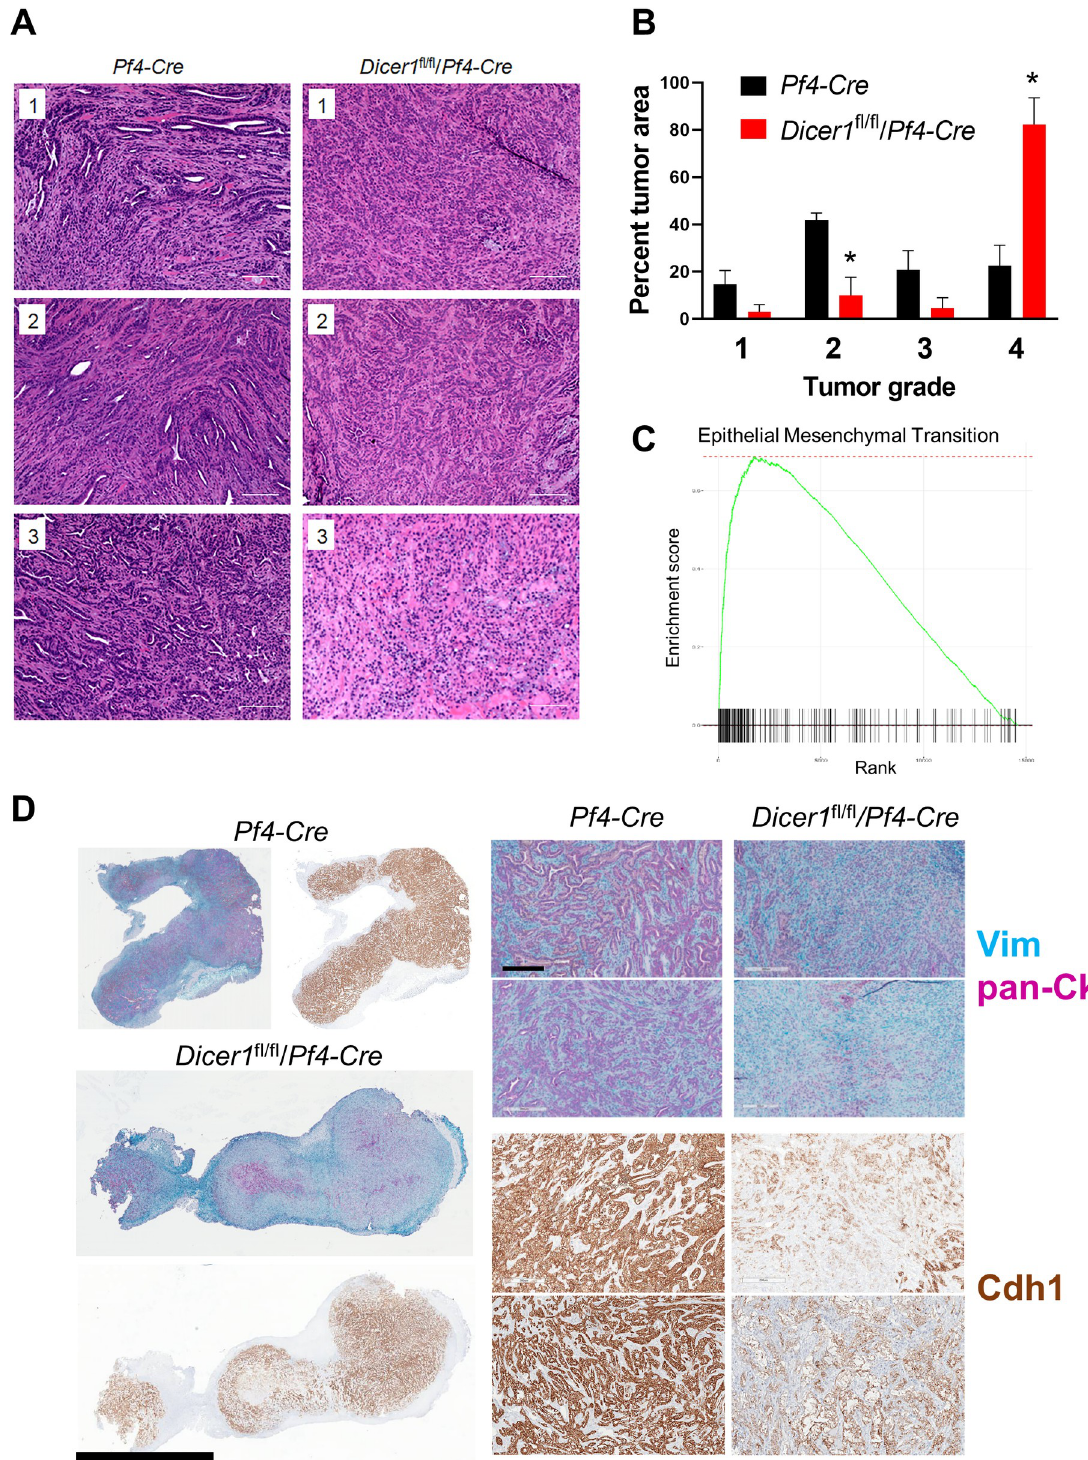
Fig 4. Increased tumor cell plasticity in ectopic tumors in platelet miRNA-depleted mice. Resected KPC primary tumors from Pf4-Cre or Dicer1 fl/fl / Pf4-Cre mice were sectioned and processed for staining with hematoxylin and eosin, or staining for Cdh1, Ck and Vim. Whole slides were scanned for analysis. A Images (20x magnification) are representative of at least 5 separate image frames per tumor from 3 mice per genotype (#1–3 each). Bars, 200 μ m. B Percent tumor area by grade from ( A ) + s.e.m. n = 3. � , p < 0.05. C Hallmark enrichment plot for Epithelial Mesenchymal Transition from S2 Table . D Whole tumor sections (left) and higher